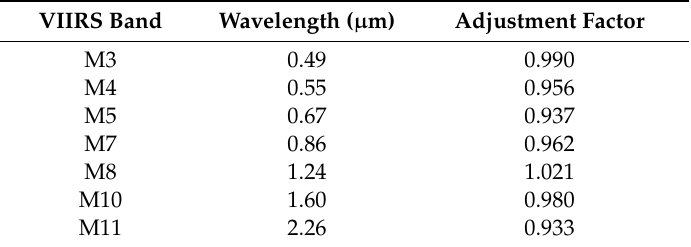
Table 2. Calibration adjustment factors by sensor band for the VIIRS SNPP level 1b reflectances, from Sayer et al. [54].